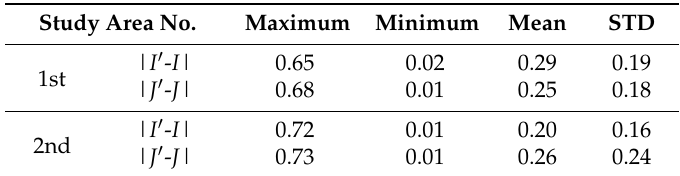
Table 7. Statistical analysis for the different image coordinates obtained by Matlab and FPGA (unit: pixel).